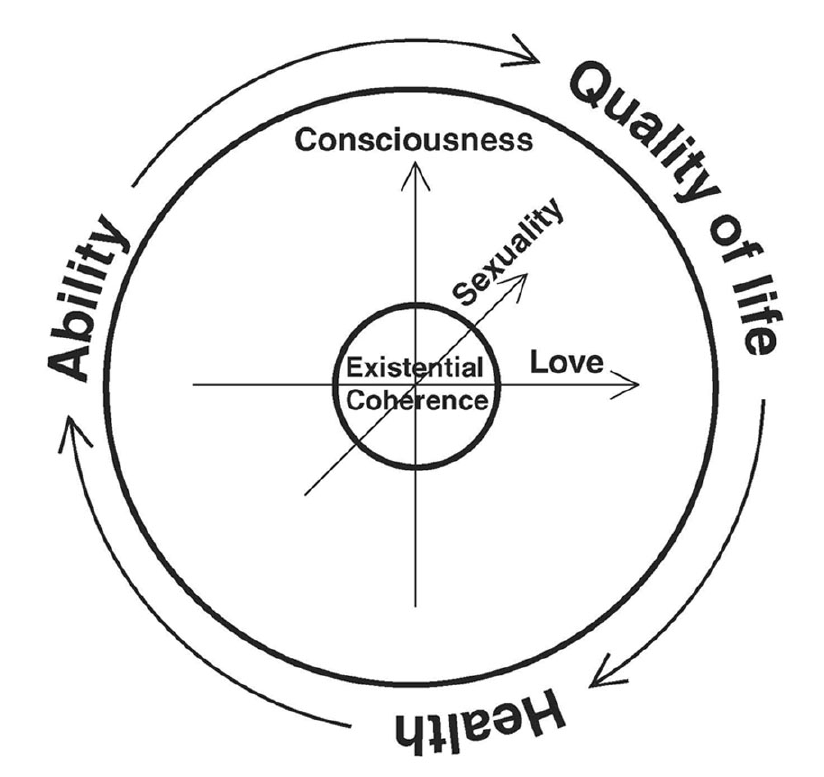
FIGURE 1. The human existence consists of three layers: 1) the layer of global quality of life (QOL), mental/physical health and ability, 2) the layer of love, power/consciousness and sexuality, and 3) the layer of existential coherence, where life inside the human being coheres with the outside world. When the patient, or spiritually seeking person, goes still deeper towards the innermost core of existence (s)he will one day confront the most fundamental question in life: To be, or not to be. This is the birth of the suicidal crises, which can only be definitely terminated by the patient deciding unconditionally to live. This decision must be taken autonomously, that is without any kind of pressure of external